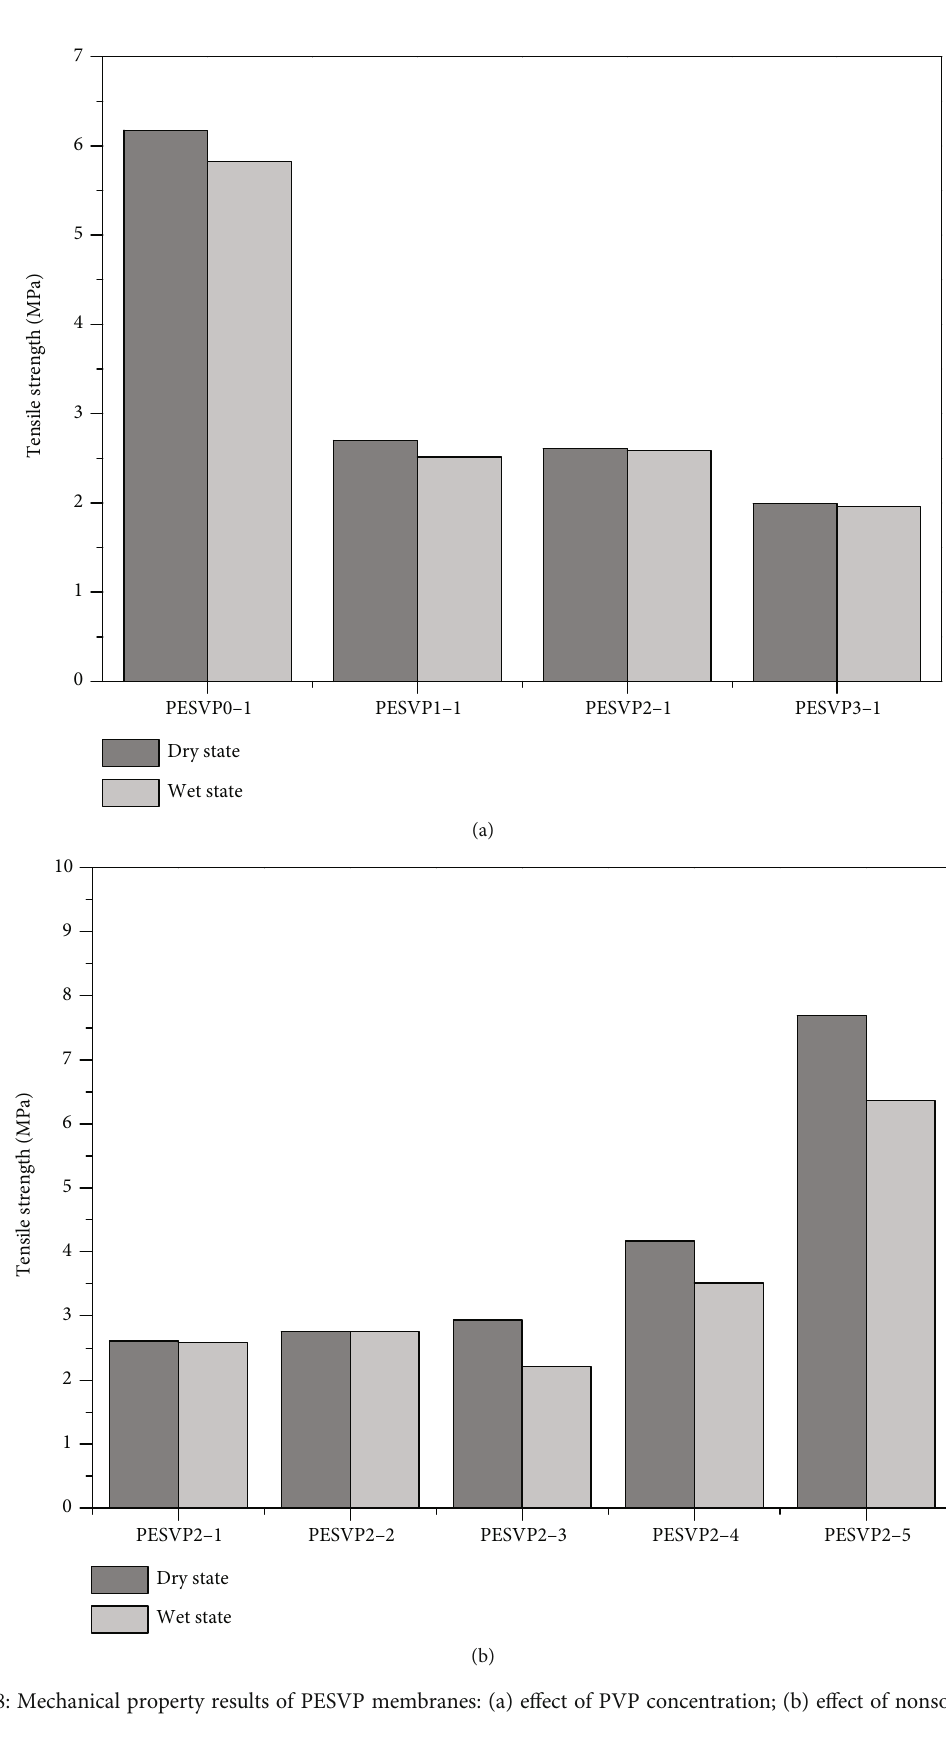
Figure 8: Mechanical property results of PESVP membranes: (a) e ff ect of PVP concentration; (b) e ff ect of nonsolvent